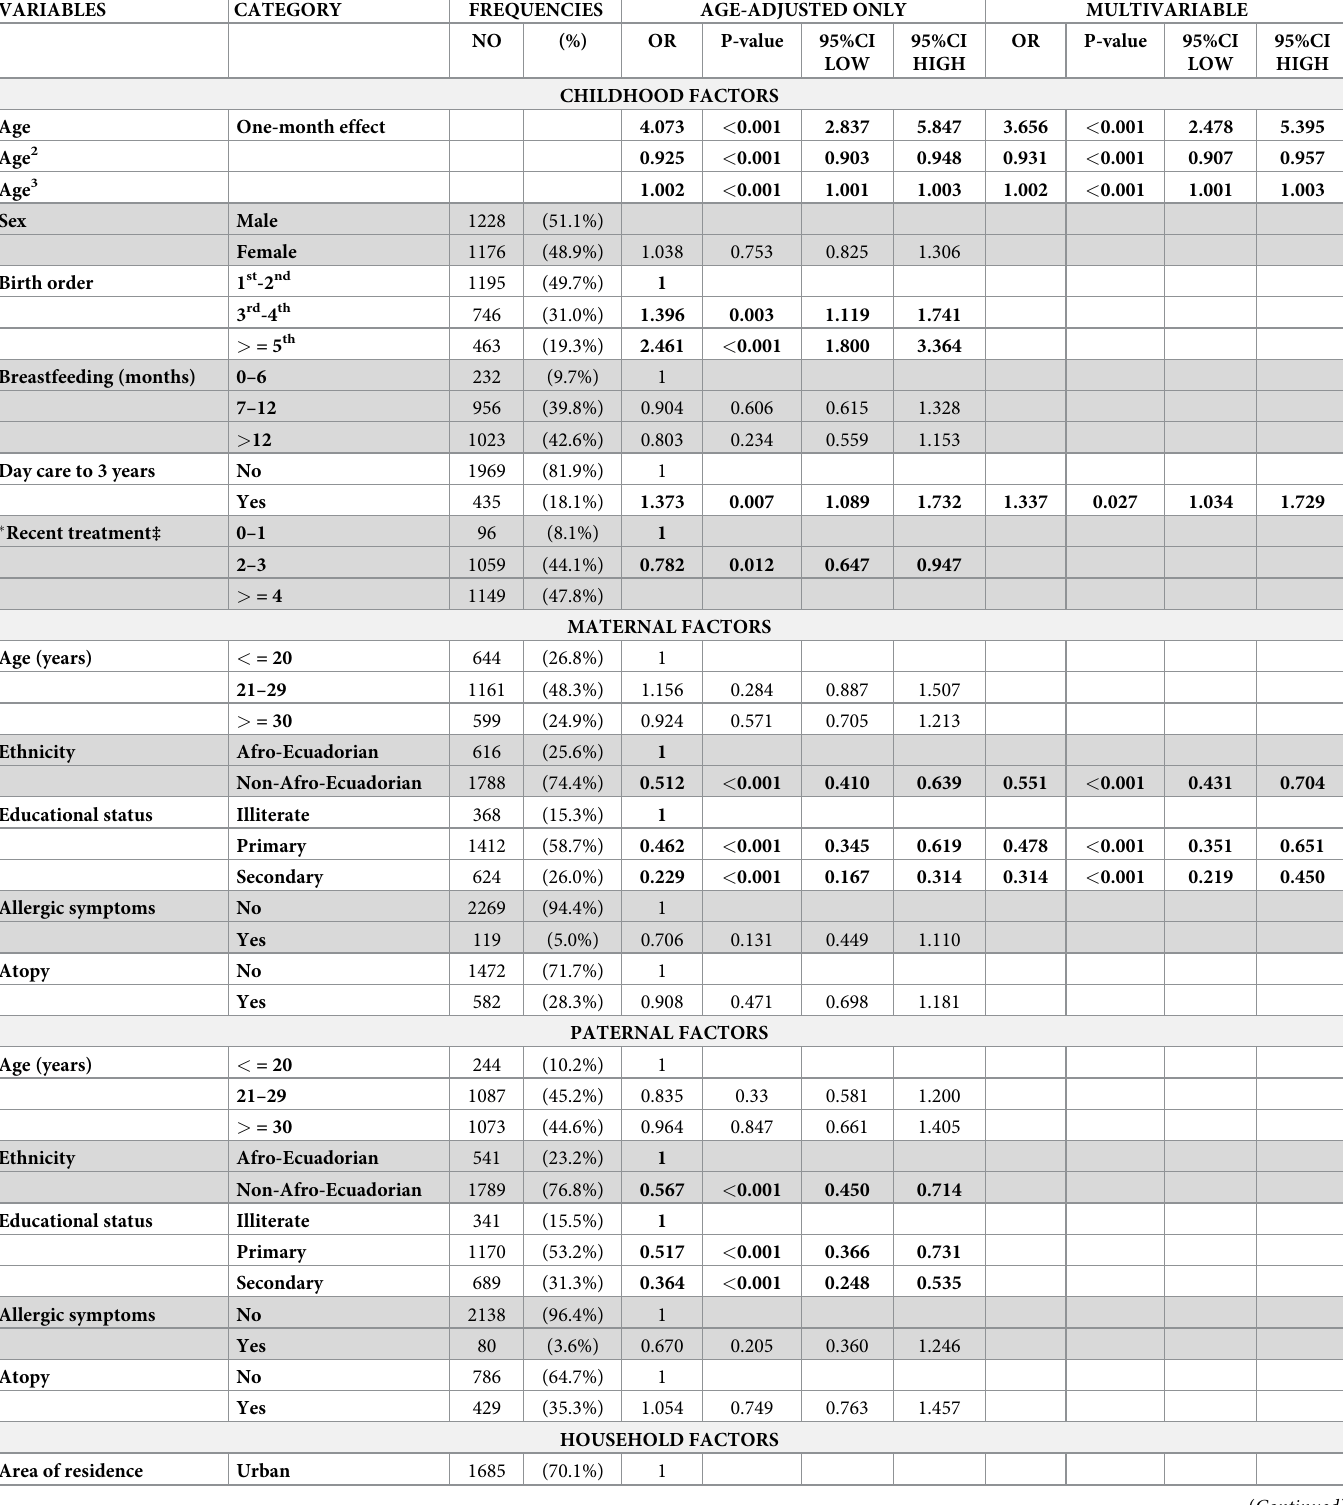
Table 1. Age-adjusted and multivariable associations between any soil-transmitted helminth (STH) infection during first 8 years of life and individual, parental, and household factors including STH infections among household members.